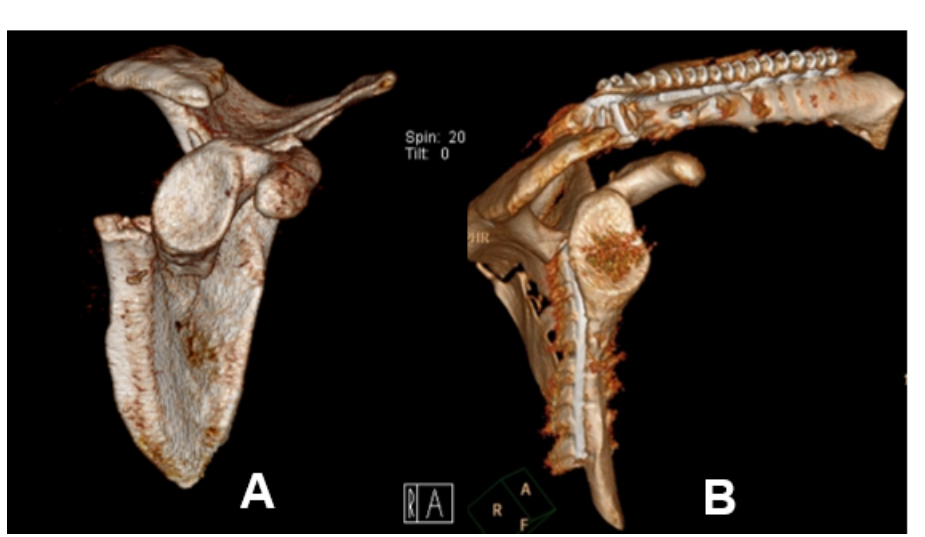
Figure 4. Concomitant intra-articular injuries detected through preoperative magnetic resonance imaging (MRI) and of affected shoulder.